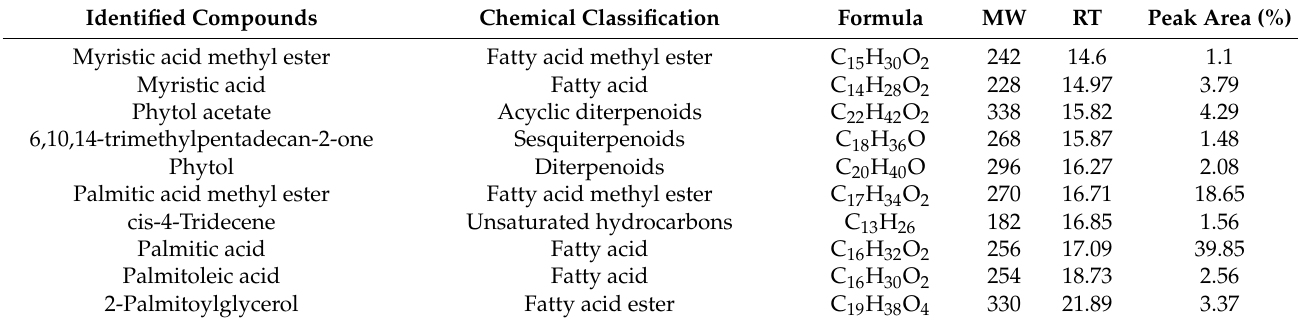
Table 3. Bioactive components of the hexane extract from Sargassum spp.